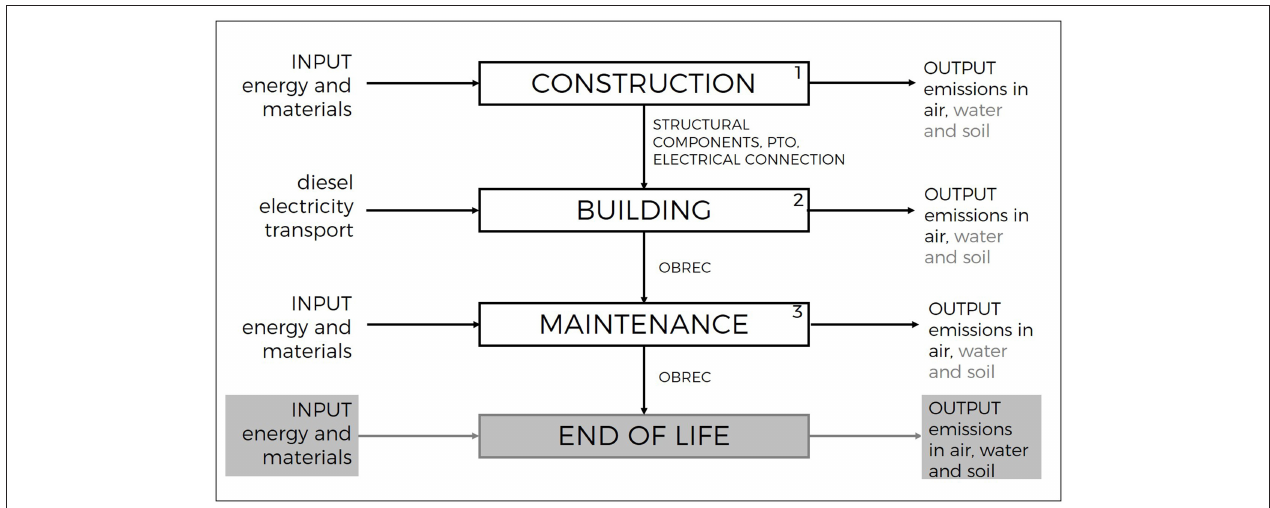
FIGURE 2 | Flow chart with phases of the production chain. Phase 1: production of components; Phase 2: on site installation including transport; Phase 3: maintenance during operation. Gray boxes represent flows and phases outside the system boundaries.